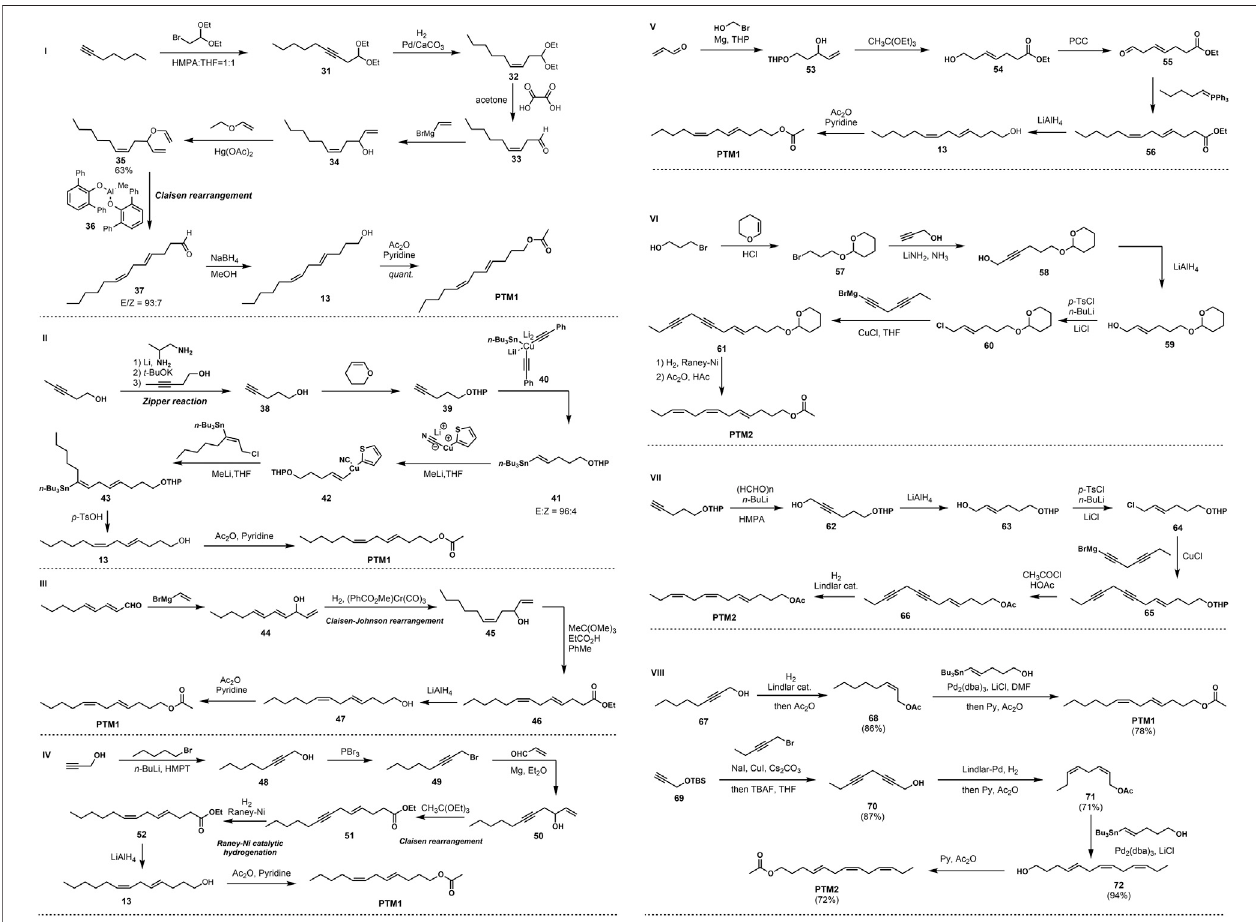
FIGURE2| INonashita ’ ssynthesisofPTM1viaClaisenrearrangementin1990.IIHutzinger ’ ssynthesisofPTM1in1995.IIIVasil ’ ev ’ ssynthesisofPTM1in1996.IV Odiokov ’ ssynthesisofPTM1in1997.VVakhidov ’ ssynthesisofPTM1in2007.VIVoerman ’ ssynthesisofPTM2in1978.VIIFukami ’ ssynthesisofPTM2in1978.VIIIOur group ’ s synthesis of PTM1 and PTM2 via Stille coupling in